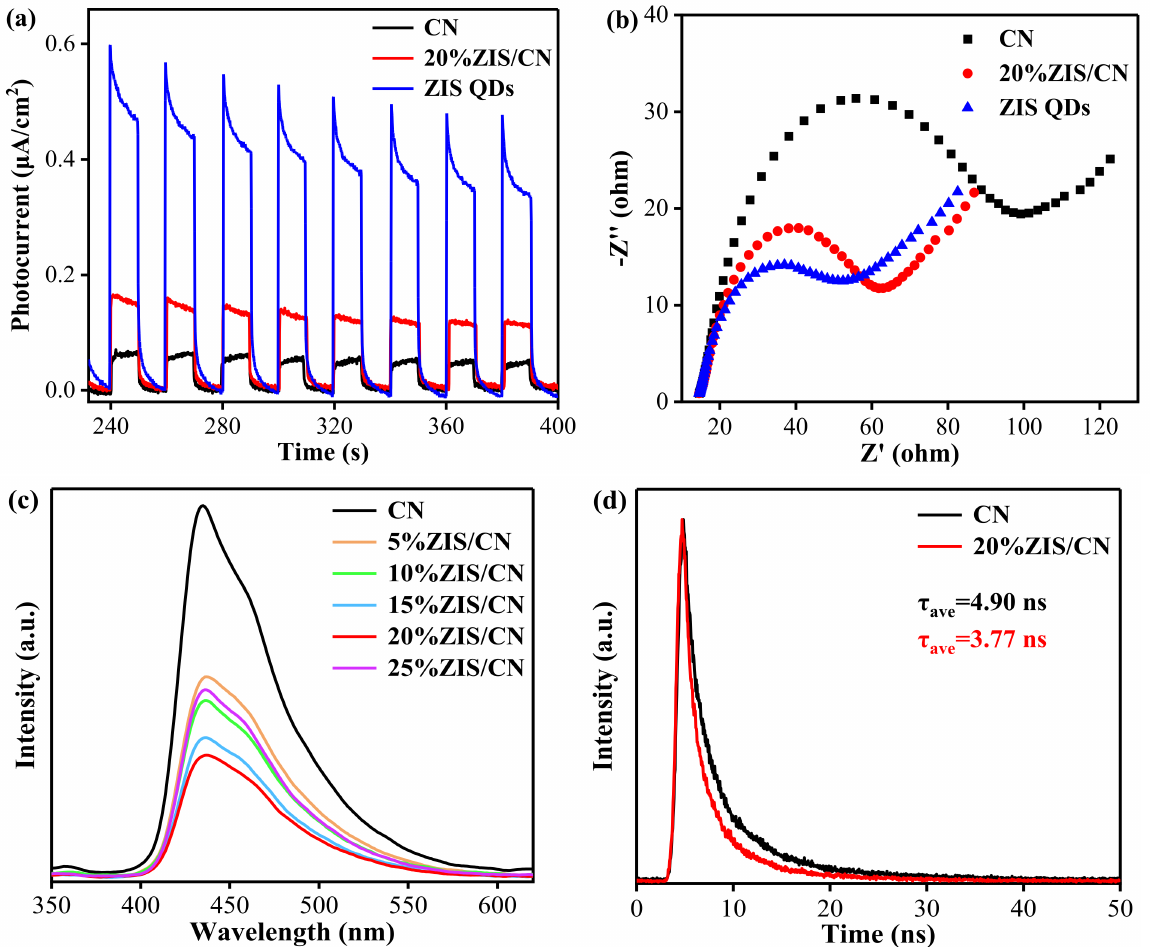
Figure 8. Photoelectric property of CN, ZIS QDs and 20%ZIS/CN samples: ( a ) photocur- rent time curve, ( b ) electrochemical impedance spectrum, ( c ) steady-state fluorescence spectra, ( d ) transient